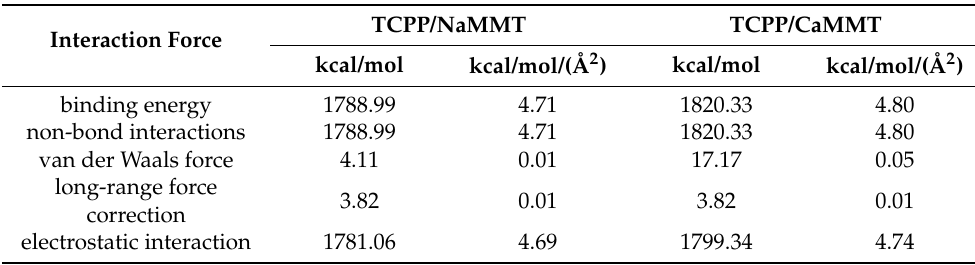
Table 2. Binding energy of TCPP with NaMMT and CaMMT.